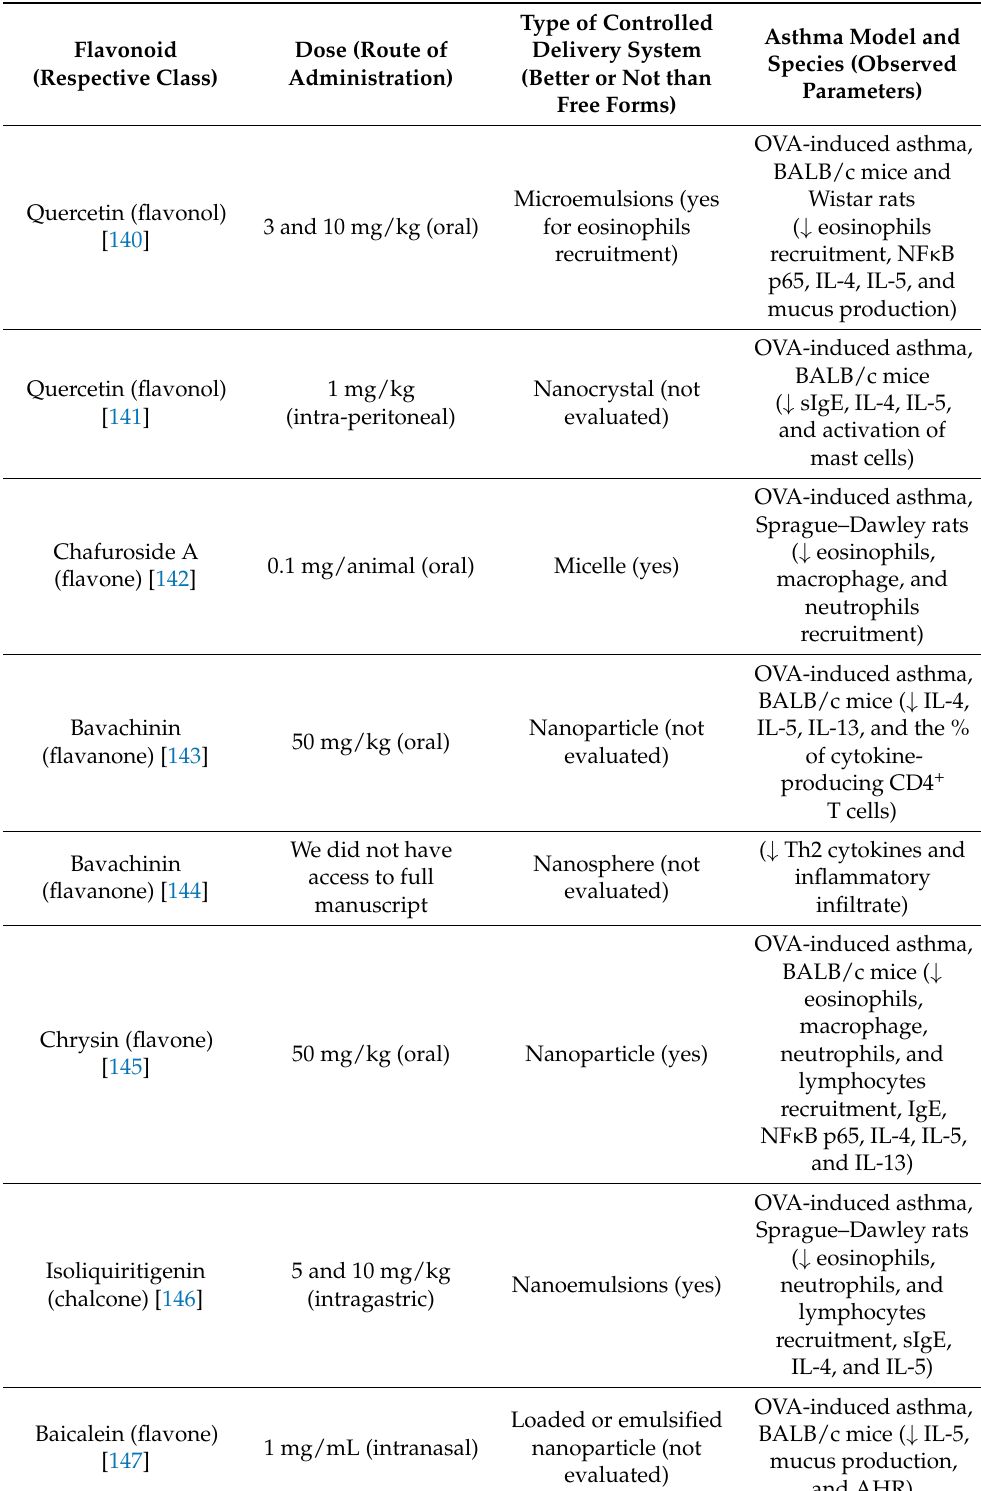
Table 1. Summary of evidence found in studies evaluating the therapeutic potential of flavonoids in asthma